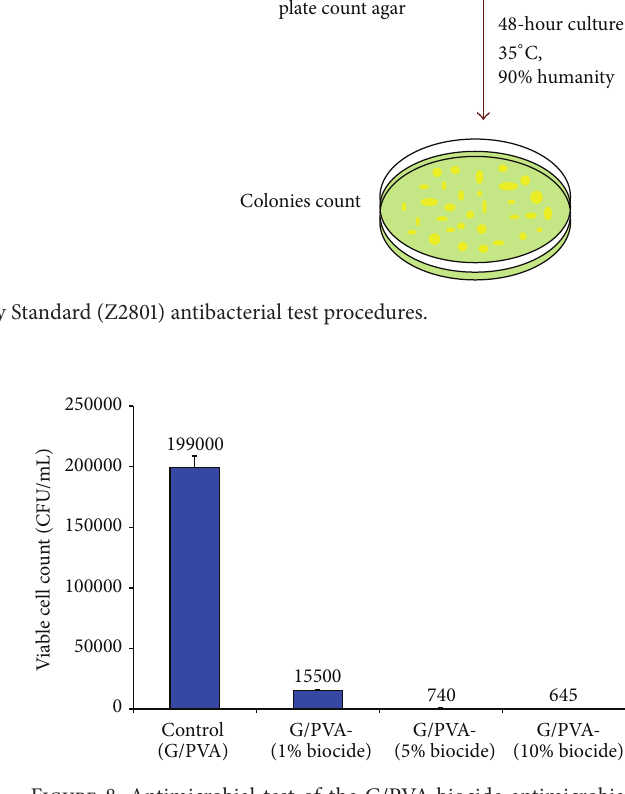
Figure 8: Antimicrobial test of the G/PVA-biocide antimicrobial nanocomposite films against S. aureus after incubation at 37 ∘ C for 24 hours and the control test film was